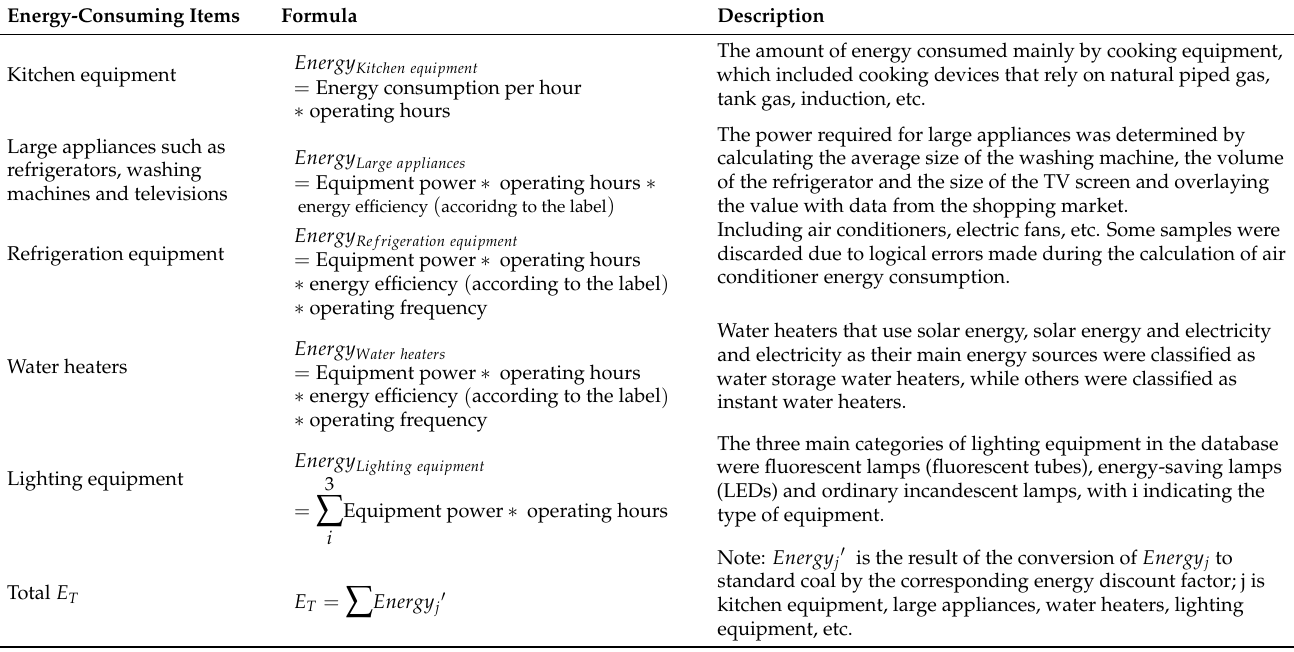
Table 1. The methods of assessing household energy consumption and direct carbon emissions of